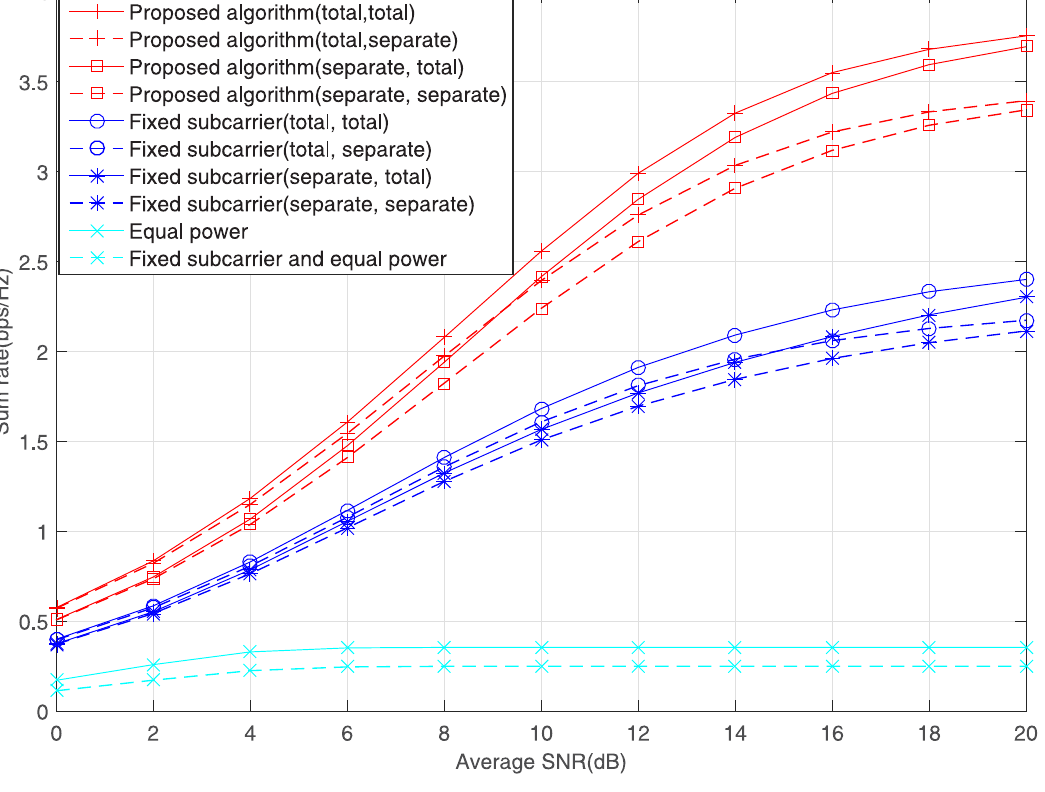
Fig 3. Effect of average SNR on the sum rate, where Q 1 = Q 2 =